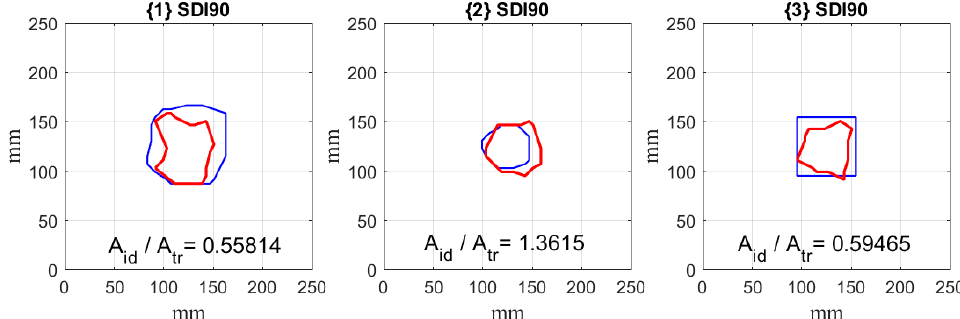
Figure 12. The quantification results for the considered damage scenarios with the ratios of areas of identified A id and true damage A tr .